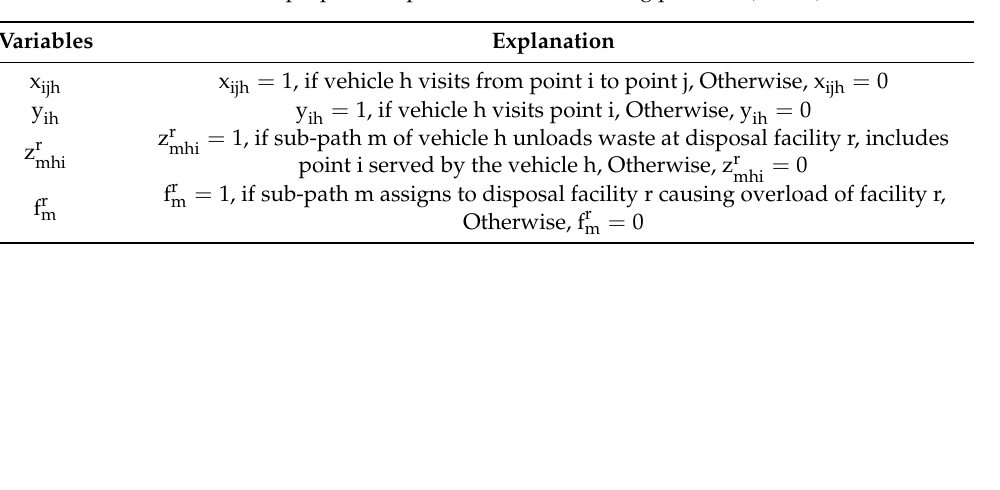
Table 1. Notations of the proposed capacitated vehicle routing problem (CVRP) model.